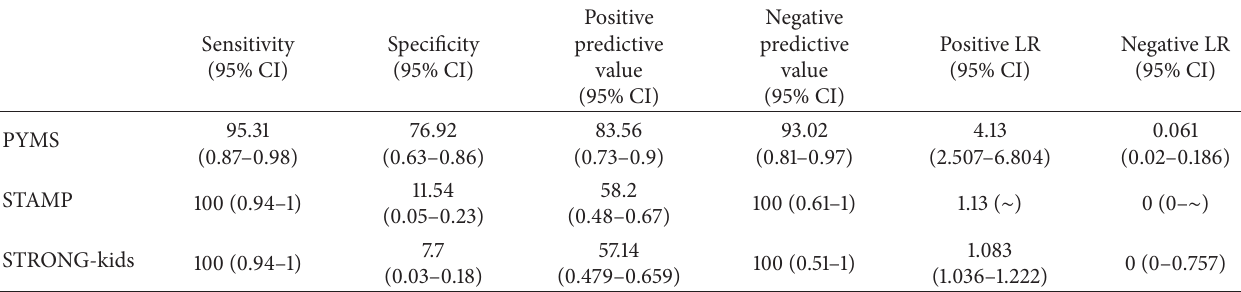
Table 4: Sensitivity, specificity, and likelihood ratio between nutritional screening tools and